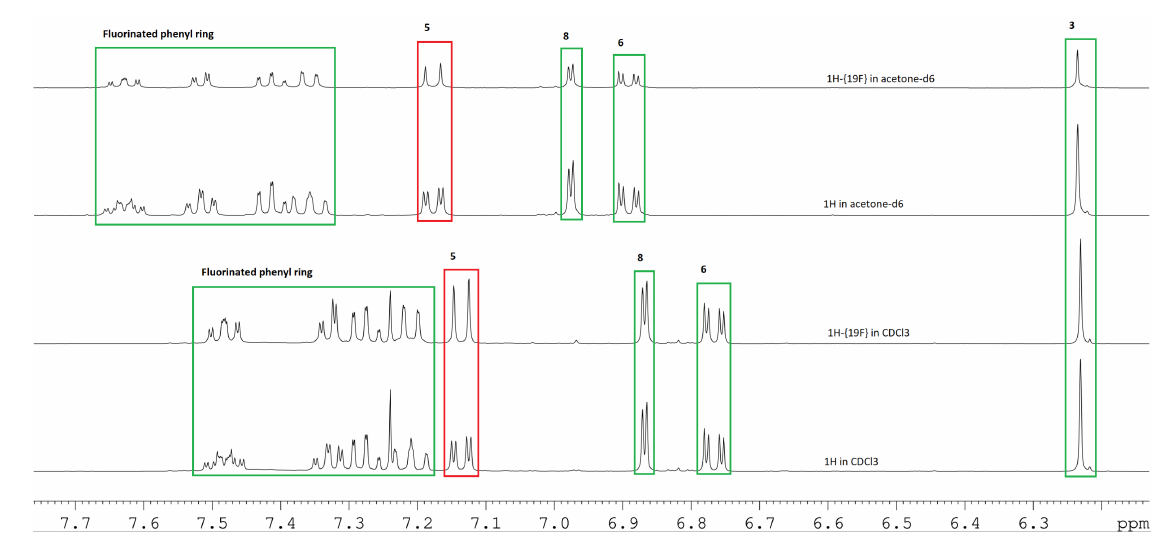
Figure 1: 1 H NMR spectra for the “aromatic” region of coumarin 6 ; comparison of 1 H spectrum and 1 H-{ 19 F} spectrum in CDCl 3 and 1 H spectrum and 1 H-{ 19 F} spectrum in acetone- d 6 .